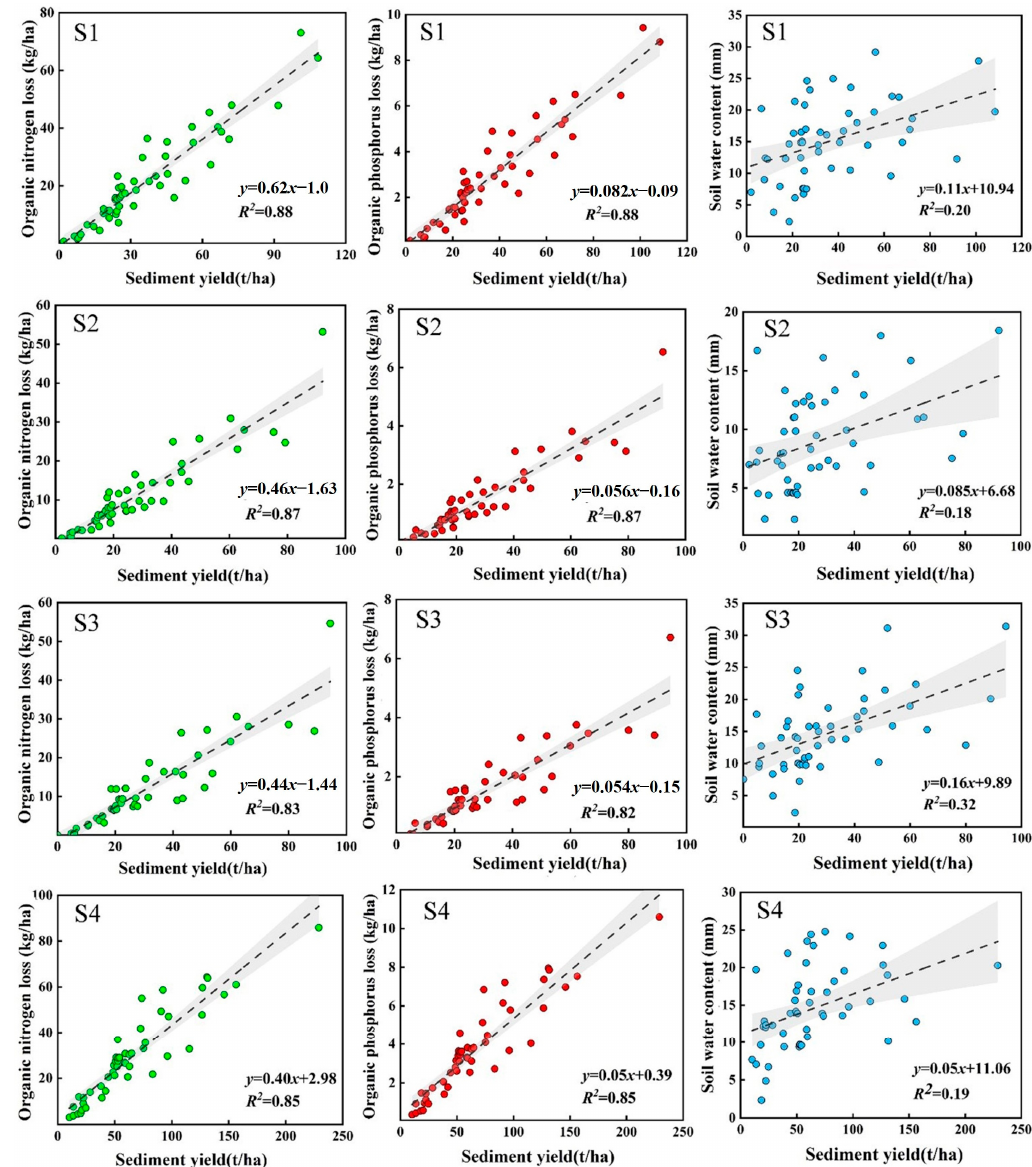
Figure 10. The relationship between soil modulus and soil water content: N loss and P loss in four scenarios.(Green dots are the organic nitrogen losses corresponding to different sediment yield; red dots are the organic phosphorus losses corresponding to different sediment yield; blue dots are the soil water content corresponding to different sediment yield).